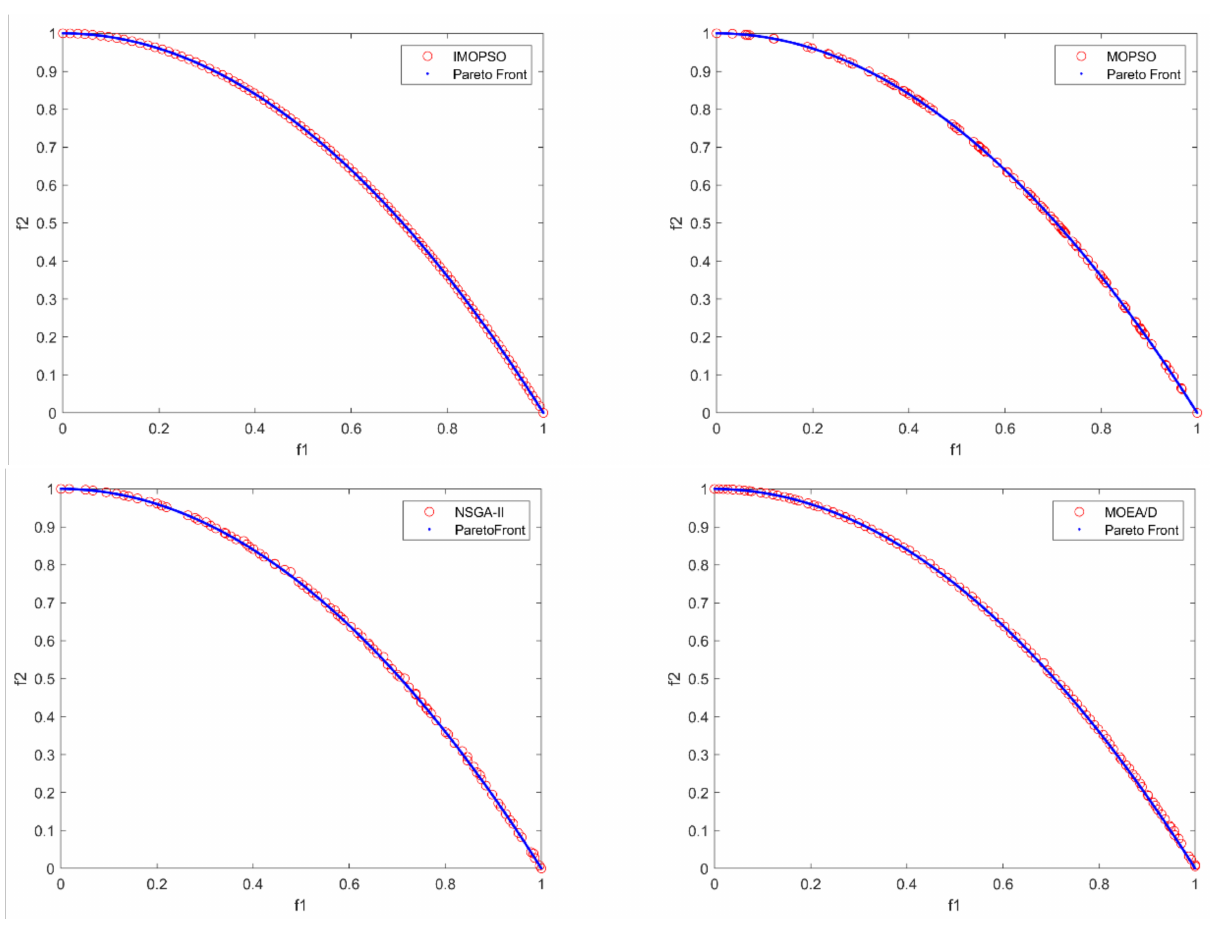
Figure 9. Comparison of the results of four algorithms for solving ZDT2 function.